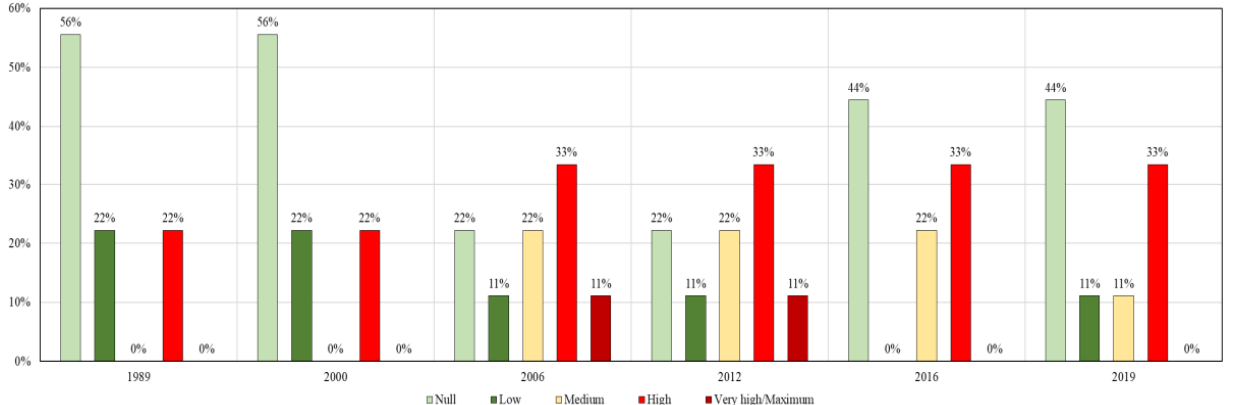
Figure 9. Percentage of F index classes per year. In 1989, the most frequent classes are the “Null” and the “Low” fragmentation ones, “Medium” fragmentation class is not represented at all, the “High” one is 21%, and the “Very High/Maximum” fragmentation class has not been found.